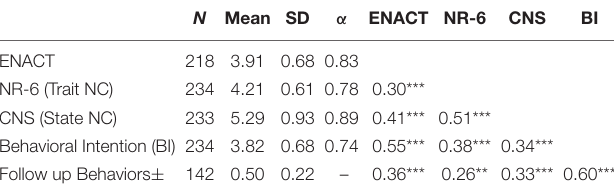
TABLE 3 | Descriptive statistics and correlations for main study